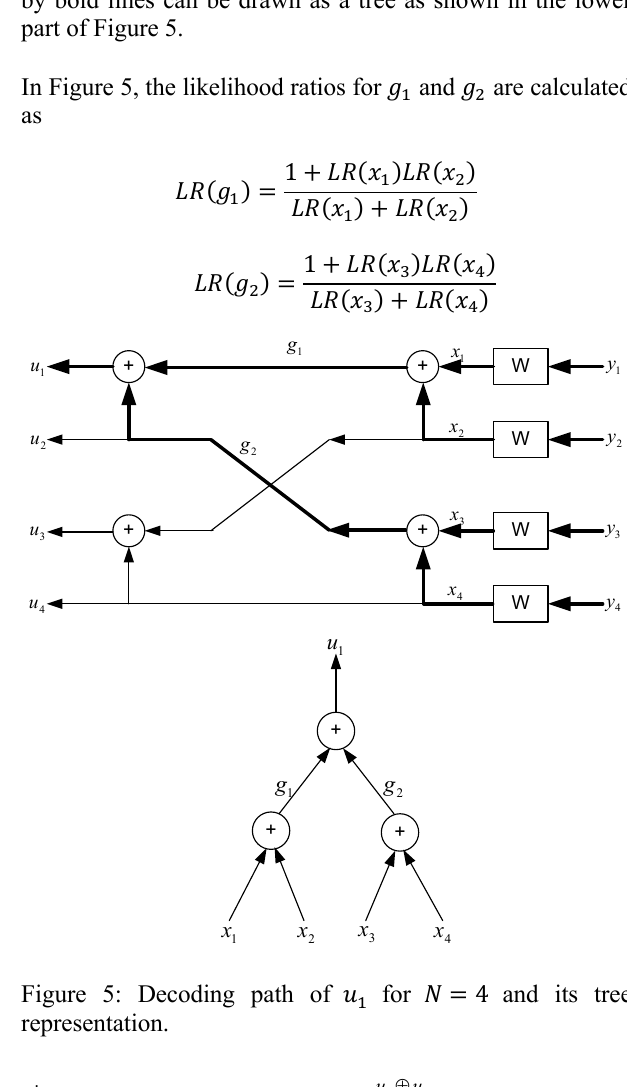
for 𝑁 = 4 and its tree 8